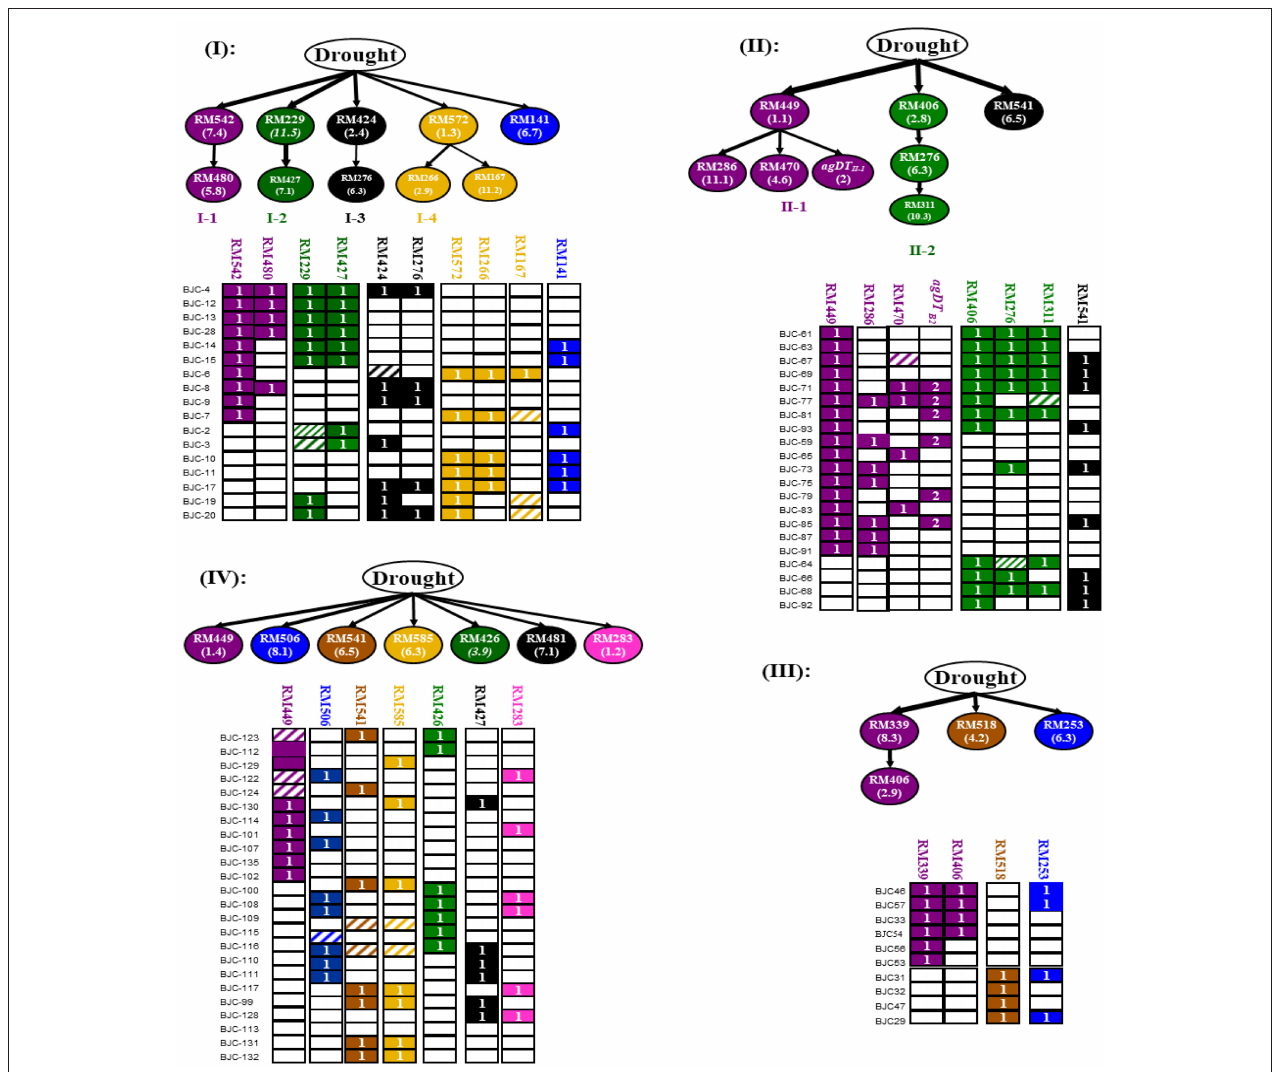
FIGURE 3 | Putative genetic networks (multi-locus structures) underlying drought tolerance (DT) of rice detected in JG88 backcross introgression lines (BILs) from four populations. In the corresponding graphical genotypes of each network, the unfilled, fully colored, and patched cells represent the recipient homozygote, donor homozygote, and heterozygote genotypes. The numbers in the cells of each FGU are the number of loci included in the FGUs. The loci (markers) included in each of the detected association groups (AGs) are shown in Table 6 . Solid arrow lines connected two FGUs in each branch of a network represent putative functional relationships with those of high introgression as putative regulators in the upstream and those of low introgression in the downstream, and the thickness of an arrow line was proportional to the introgression frequency of the downstream FGU in Table 6